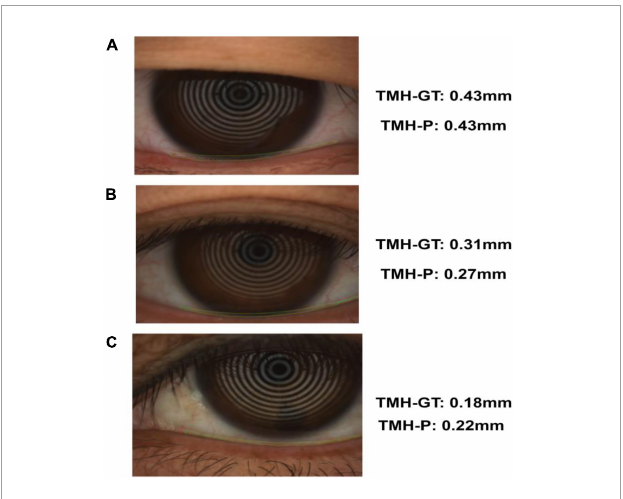
FIGURE8 Example of tear meniscus segmentation; TMH-GT indicates the TMH of label, TMH-P indicates the TMH predicted in this paper: Panel (A) is accurate segmentation (B) is under segmentation (C) is over